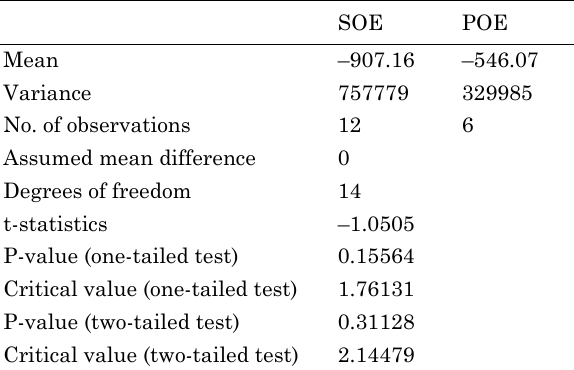
Table 10. Results of t-test between average EVA